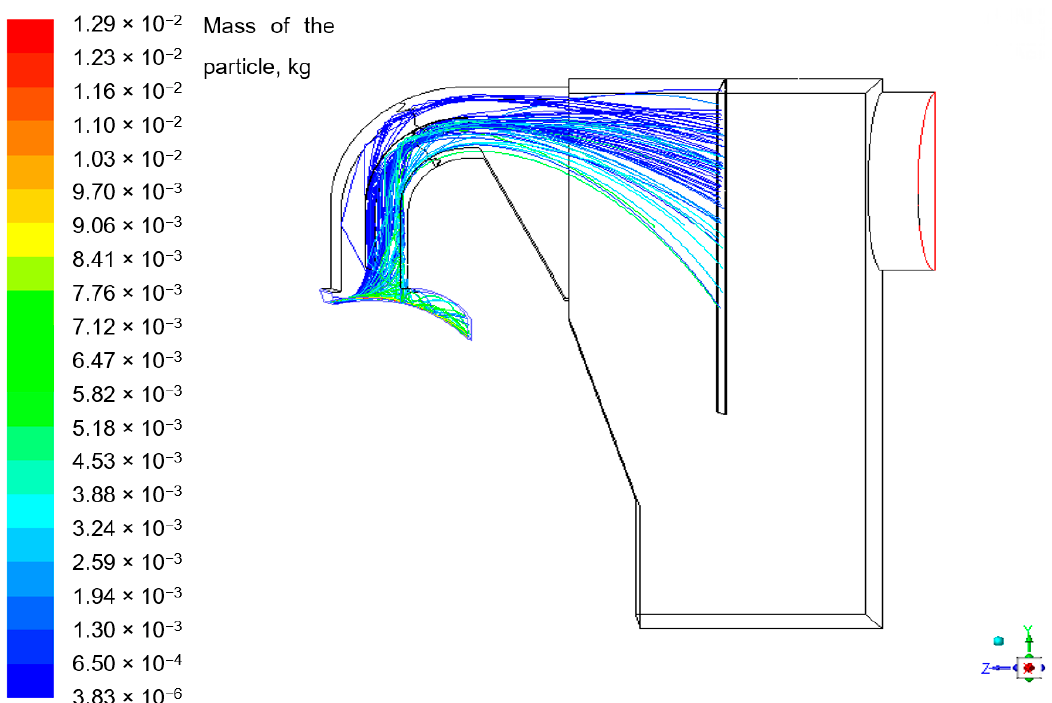
Figure 12. DPM trajectory (simulation of the main fan at 35 Hz).